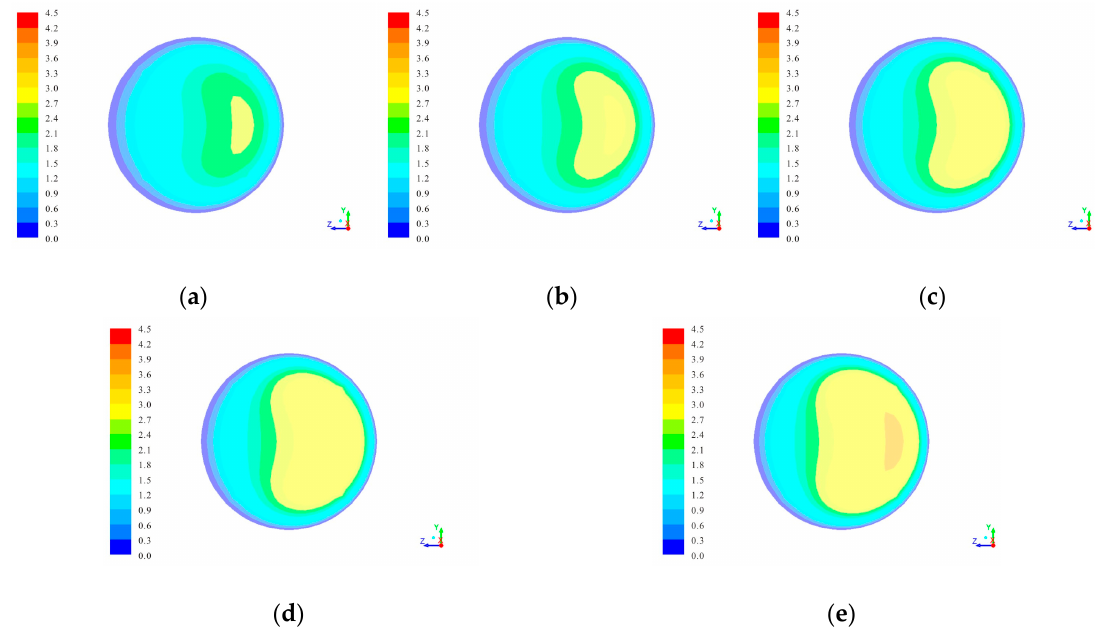
Figure 7. Velocity distribution contours with 76.05% solid concentration of CGFB slurry at different feeding velocities through the elbow pipe: ( a ) 1.4 m/s; ( b ) 1.6 m/s; ( c ) 1.8 m/s; ( d ) 2.0 m/s; ( e ) 2.2 m/s.